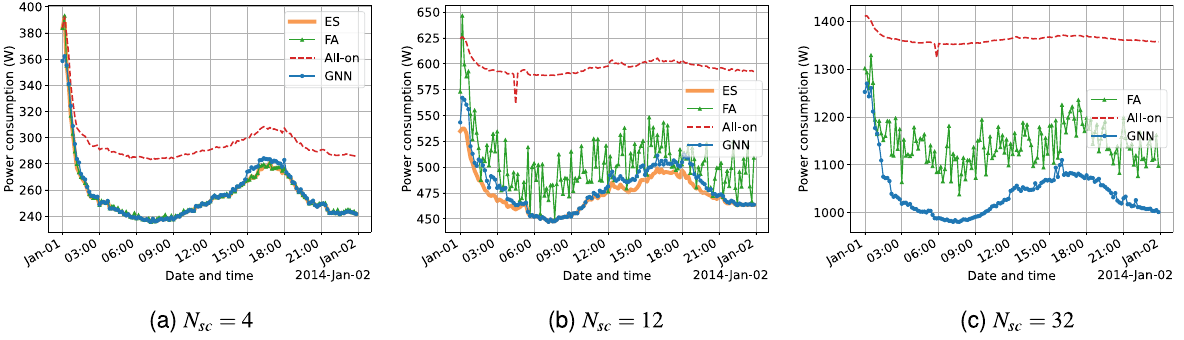
Figure 5. One-day performance results for the holiday sample (Jan. 1st, 2014) in the test set with respect to power consumption for different N sc